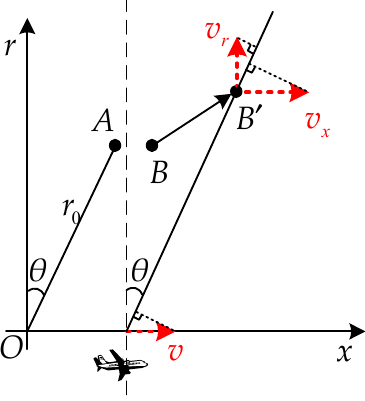
Figure 5. Doppler centroid analysis.